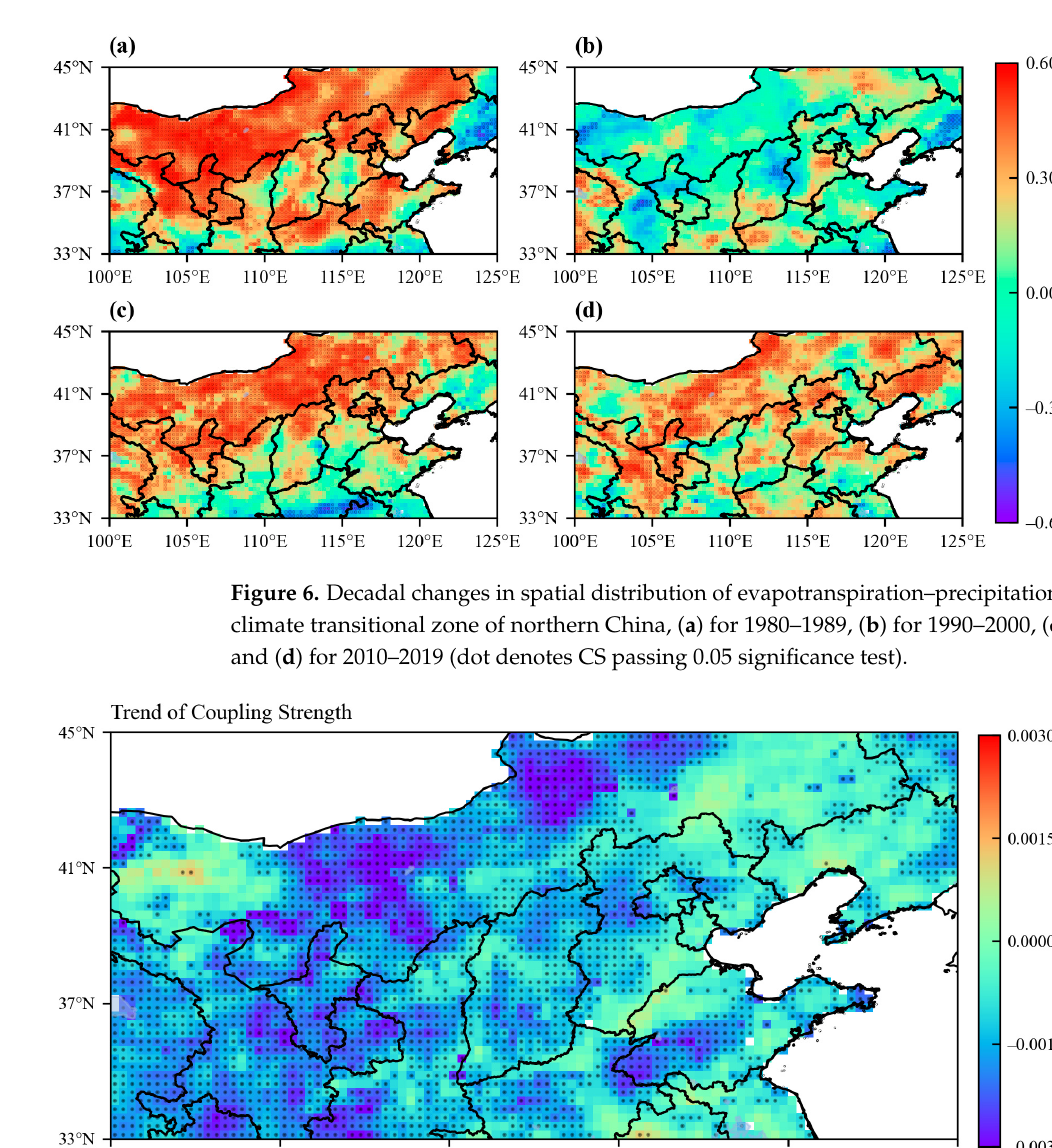
Figure 7. Spatial distribution of evapotranspiration–precipitation coupling trends in the climate transitional zone of northern China (dot denotes trend passing the significance test).